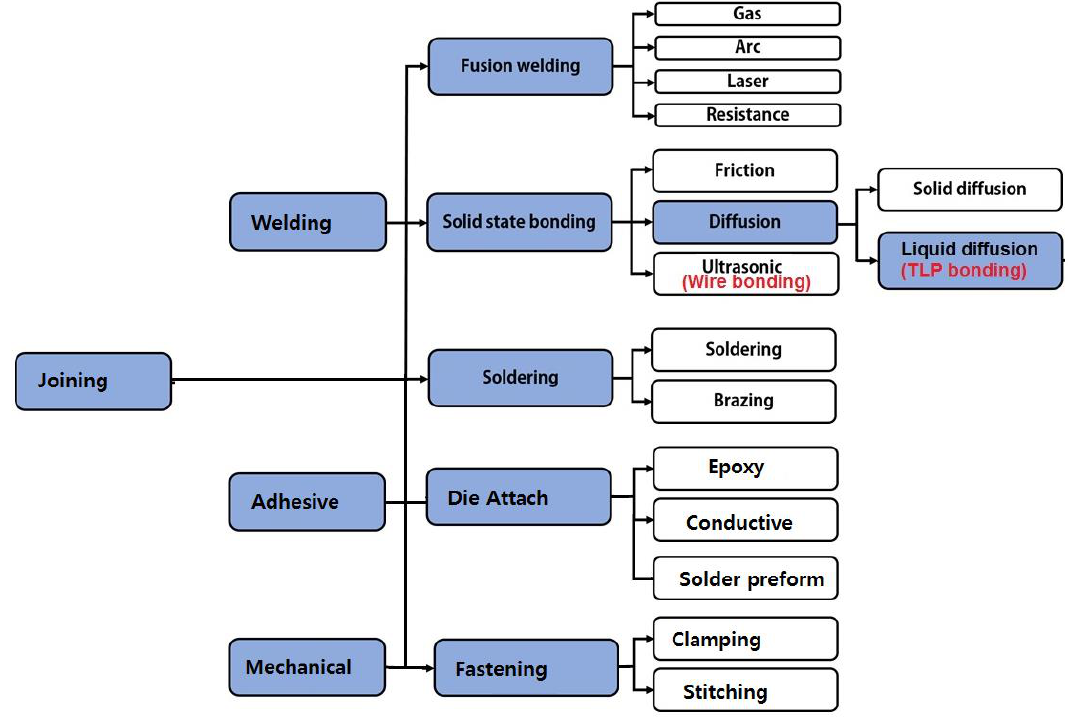
Figure 2. Classification of different types of joining processes.